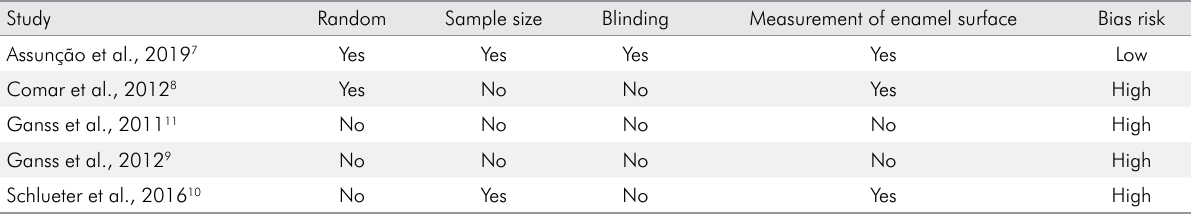
Table 2. Assessment of the risk of bias of included risk of bias studies in the systematic review. Study Random